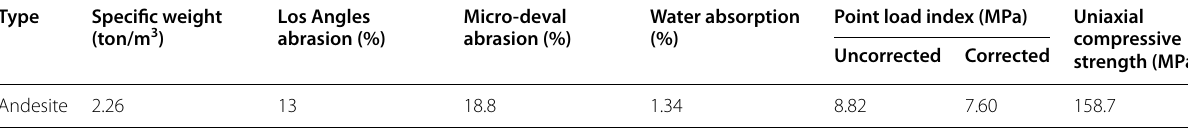
Table 5 Physical characteristics of the ballast.